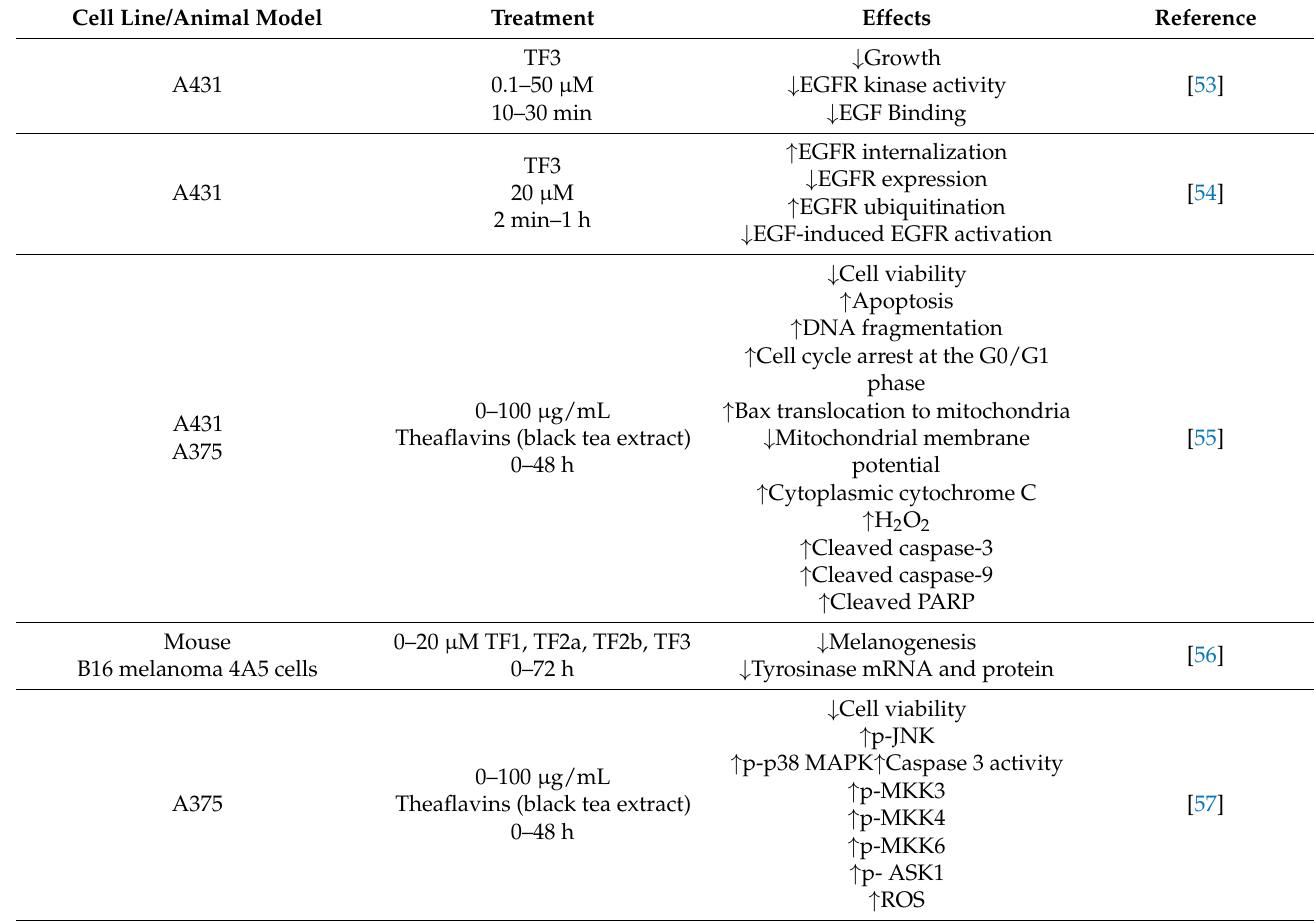
Table 7. Effects of Theaflavins on Skin